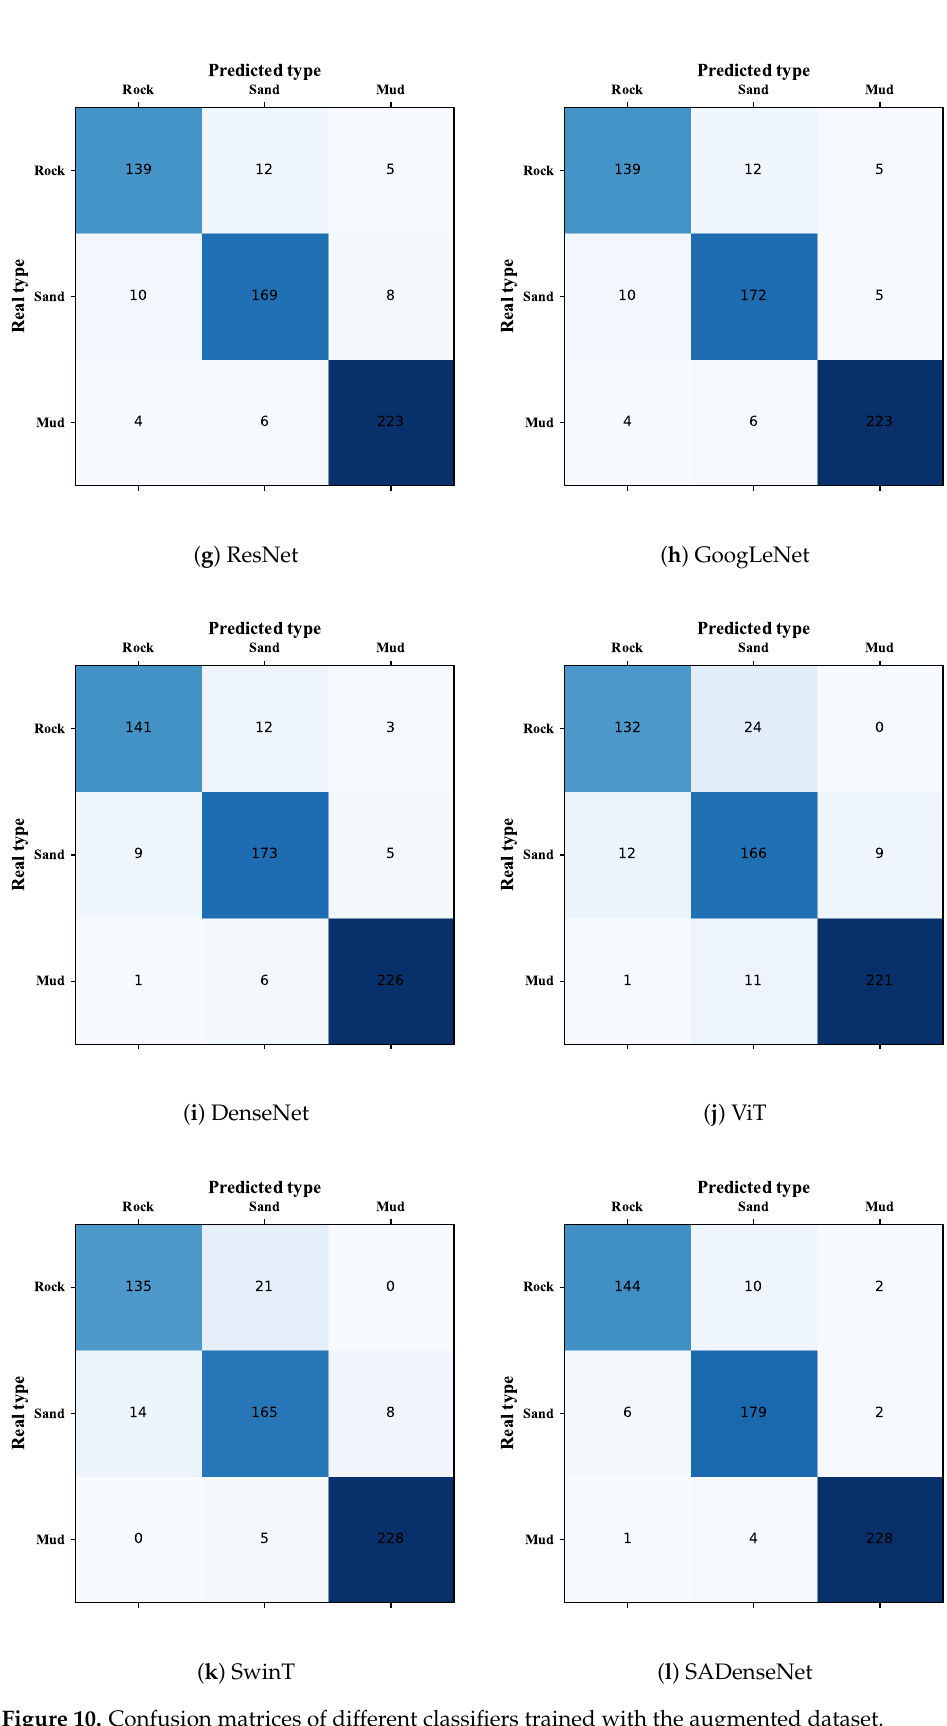
Figure 10. Confusion matrices of different classifiers trained with the augmented